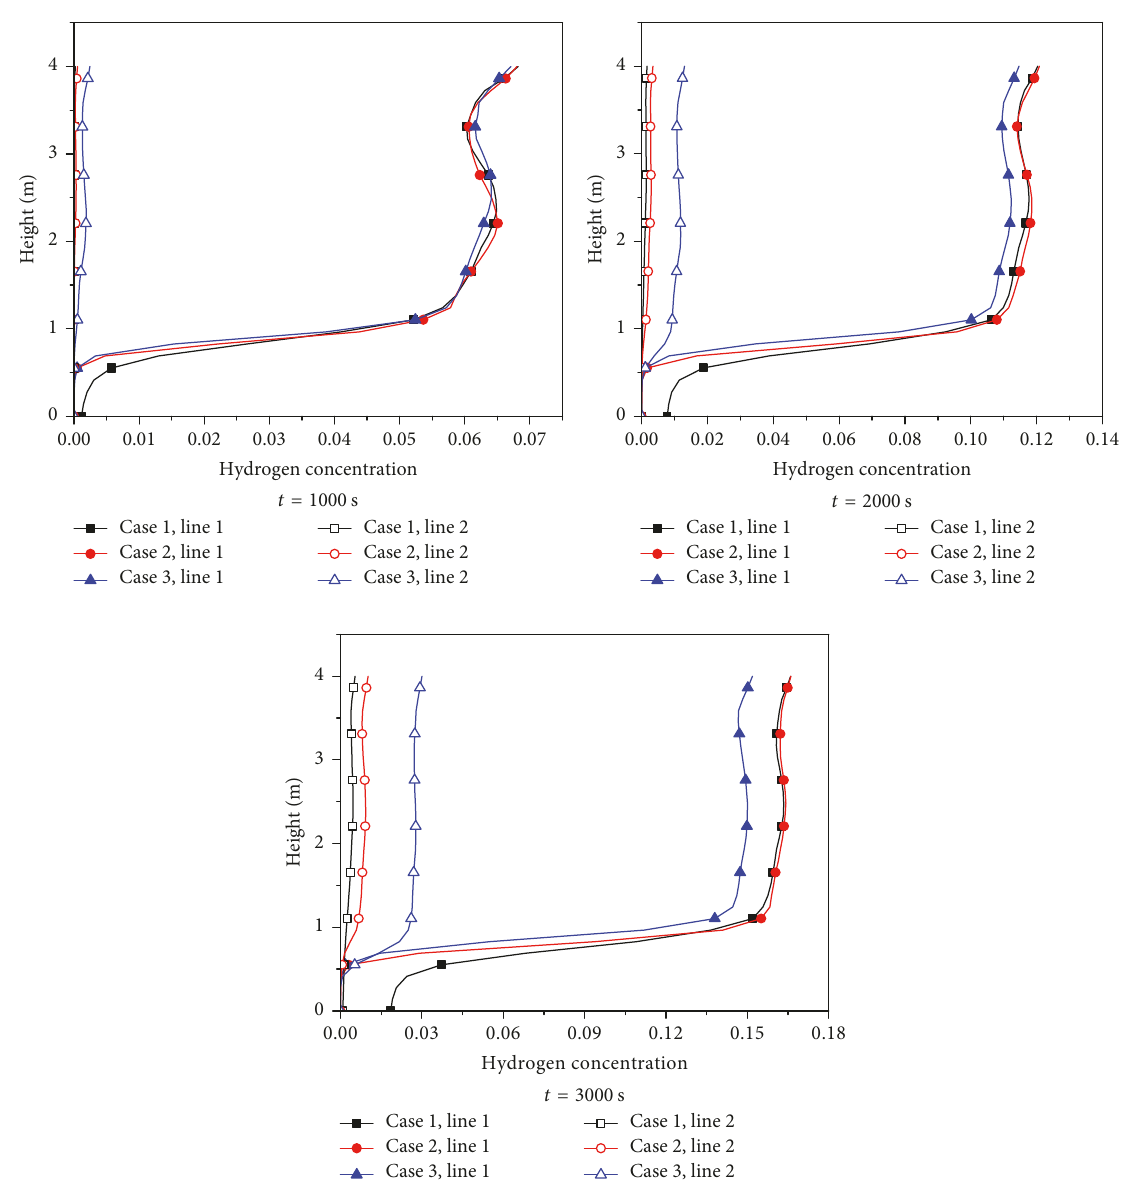
Figure 9: Hydrogen concentration at different positions in two